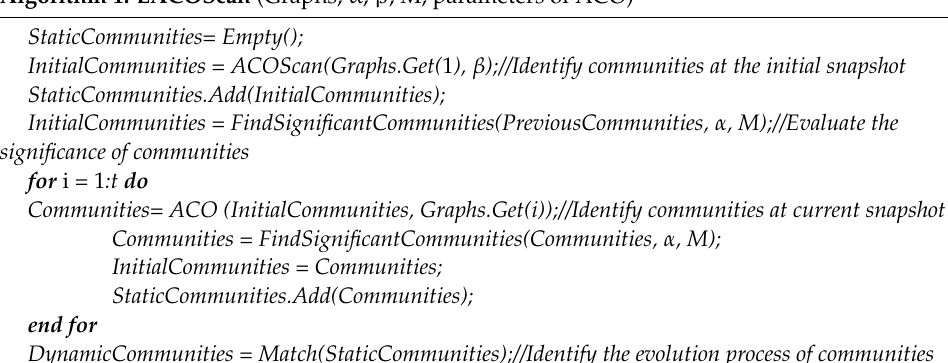
Algorithm 1: EACOScan (Graphs, α , β , M, parameters of